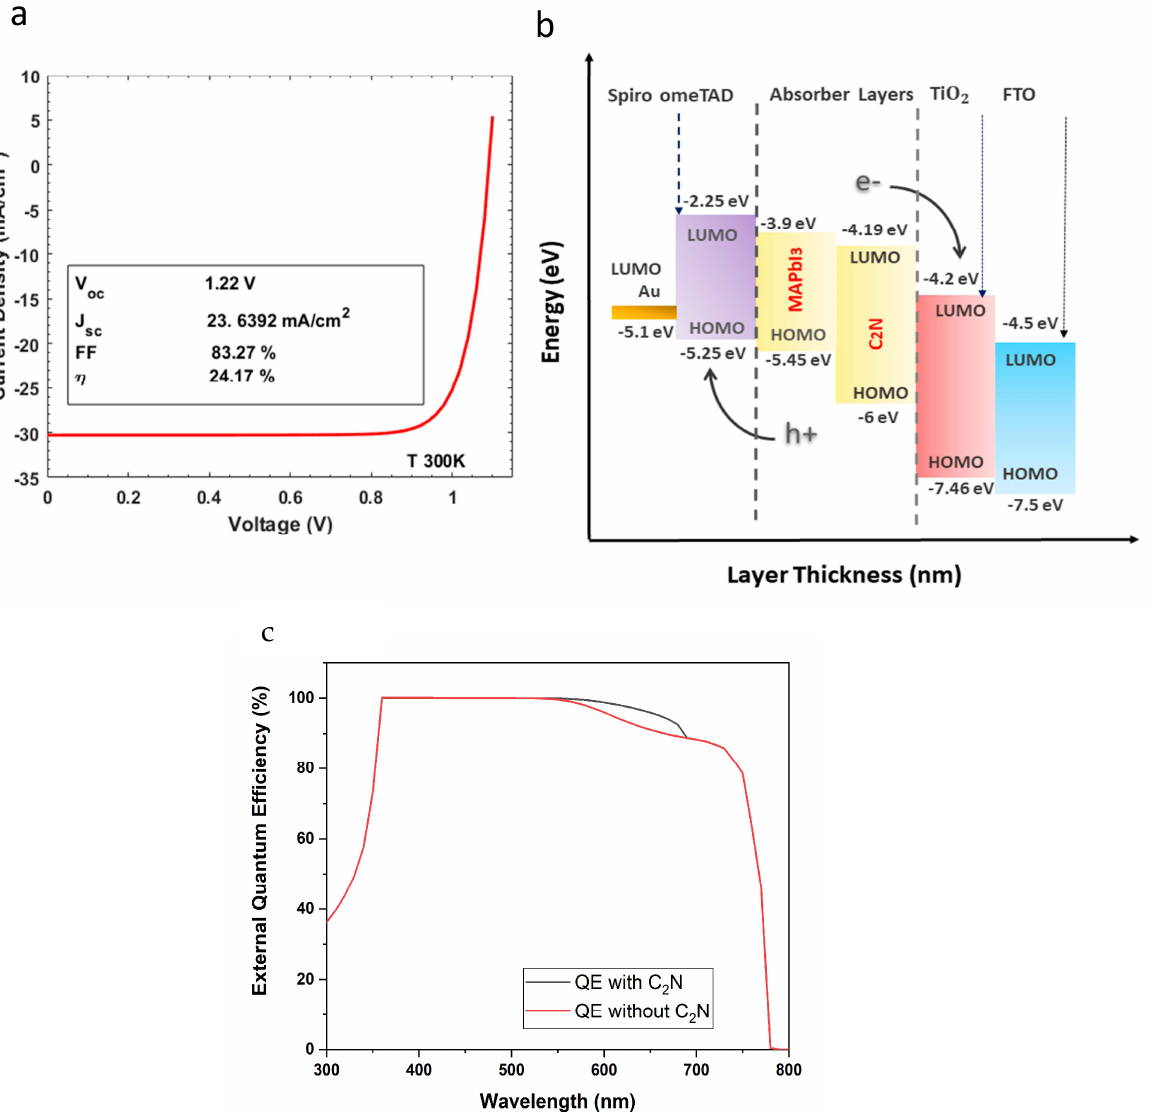
Figure 1. Proposed double-absorber-layer solar cell-layer structure.